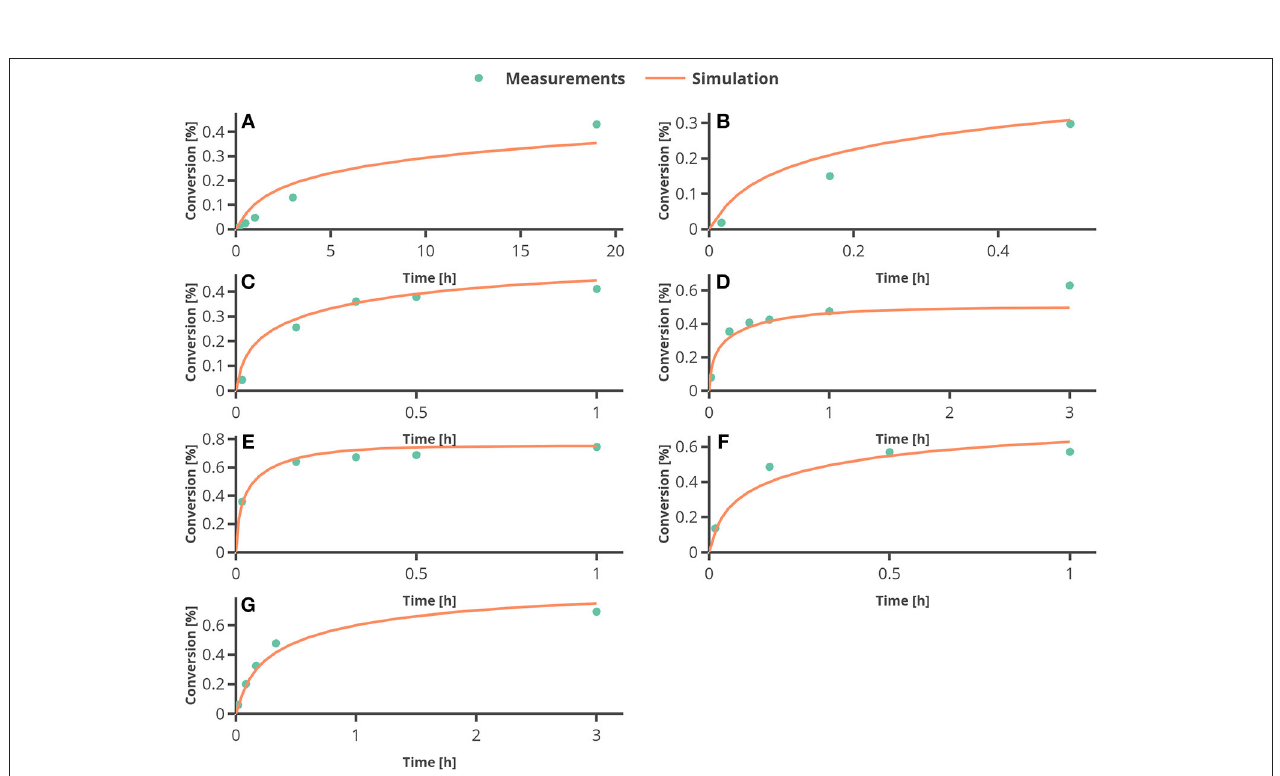
FIGURE 6 | Results from fitting the model to experimental data. (A–G) represent the experimental conditions 1–7 as in Table 3 .